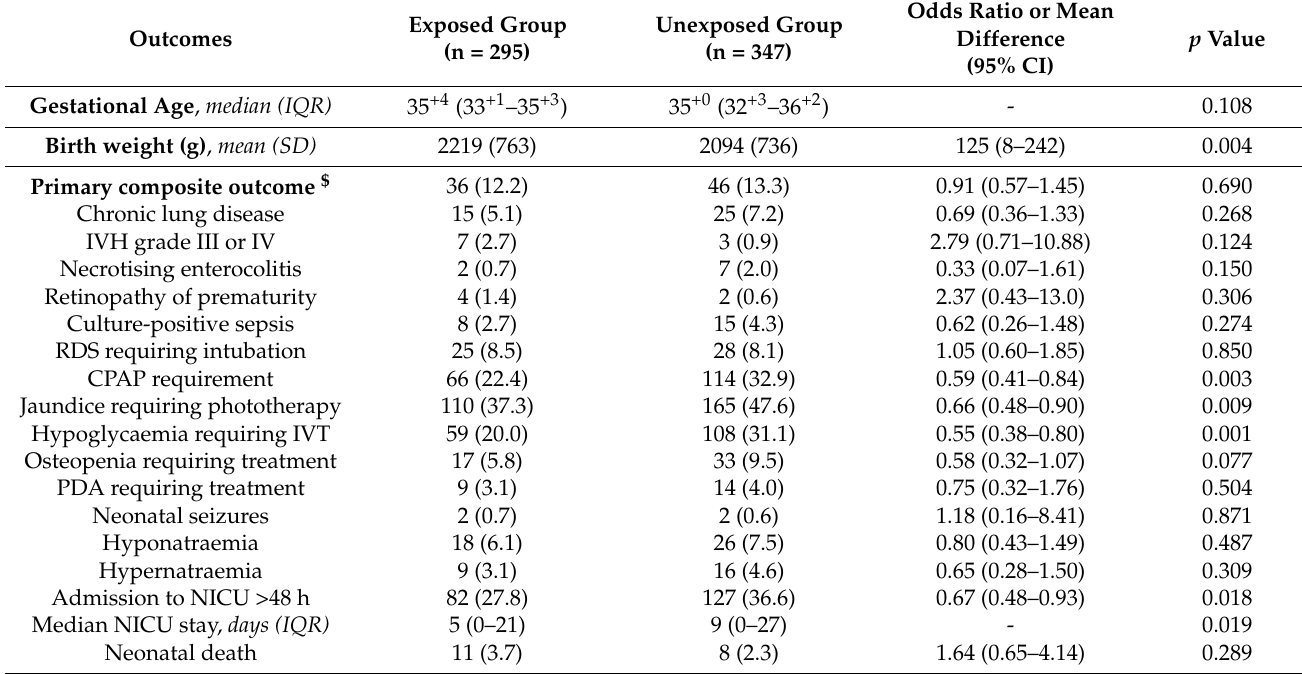
Table 1. Comparison of neonatal outcomes (live born neonates <37 weeks gestation).